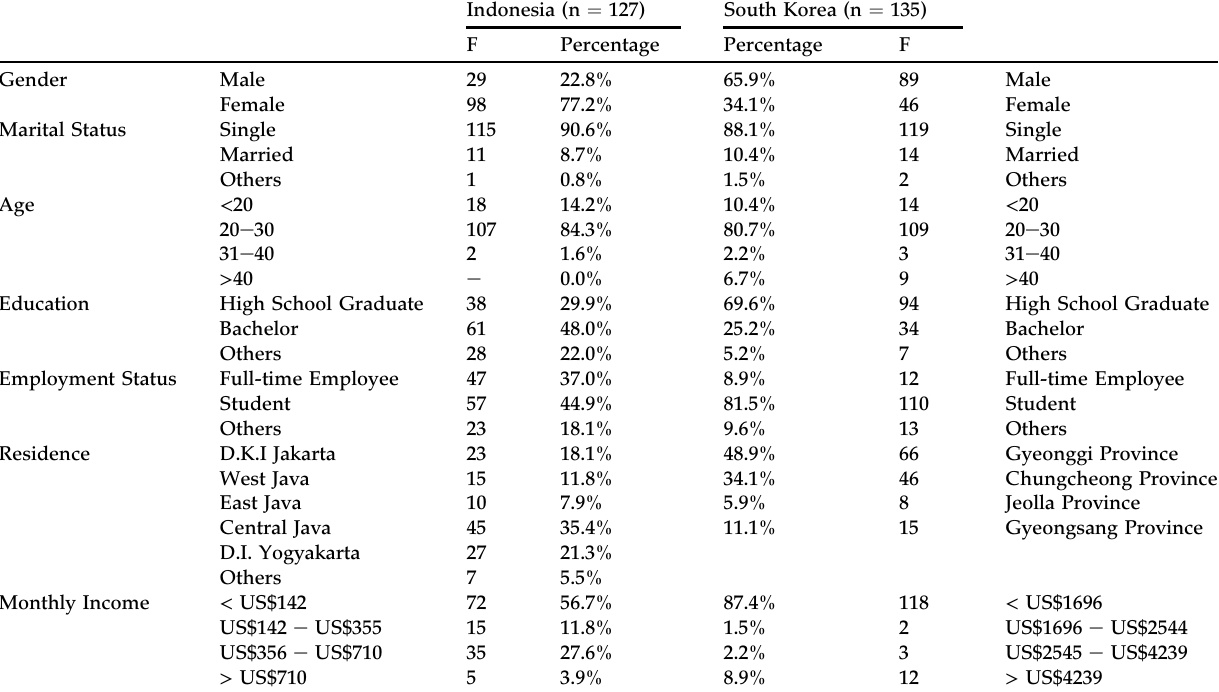
Table 2. Demographic pro fi le of